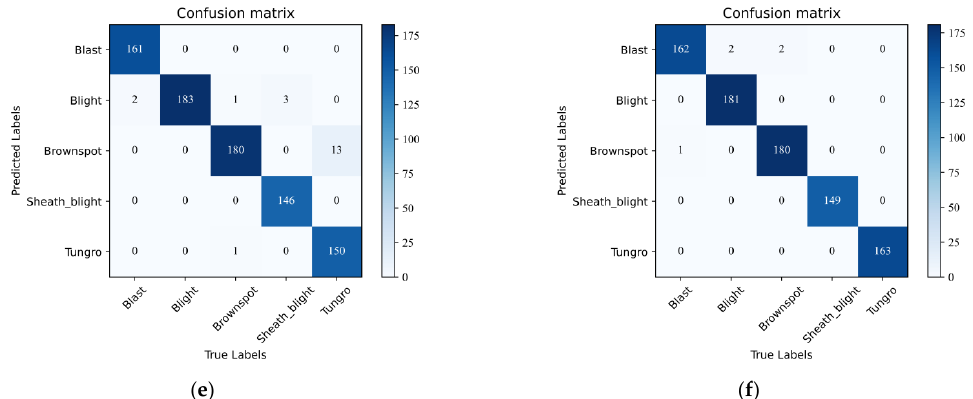
Figure 9. Confusion matrix of each model: ( a ) SE-DenseNet-1; ( b ) SE-DenseNet-2; ( c ) SE-DenseNet-3; ( d ) AB-SE-DenseNet-1; ( e ) AB-SE-DenseNet; and ( f ) AB-SE-DenseNet-3.